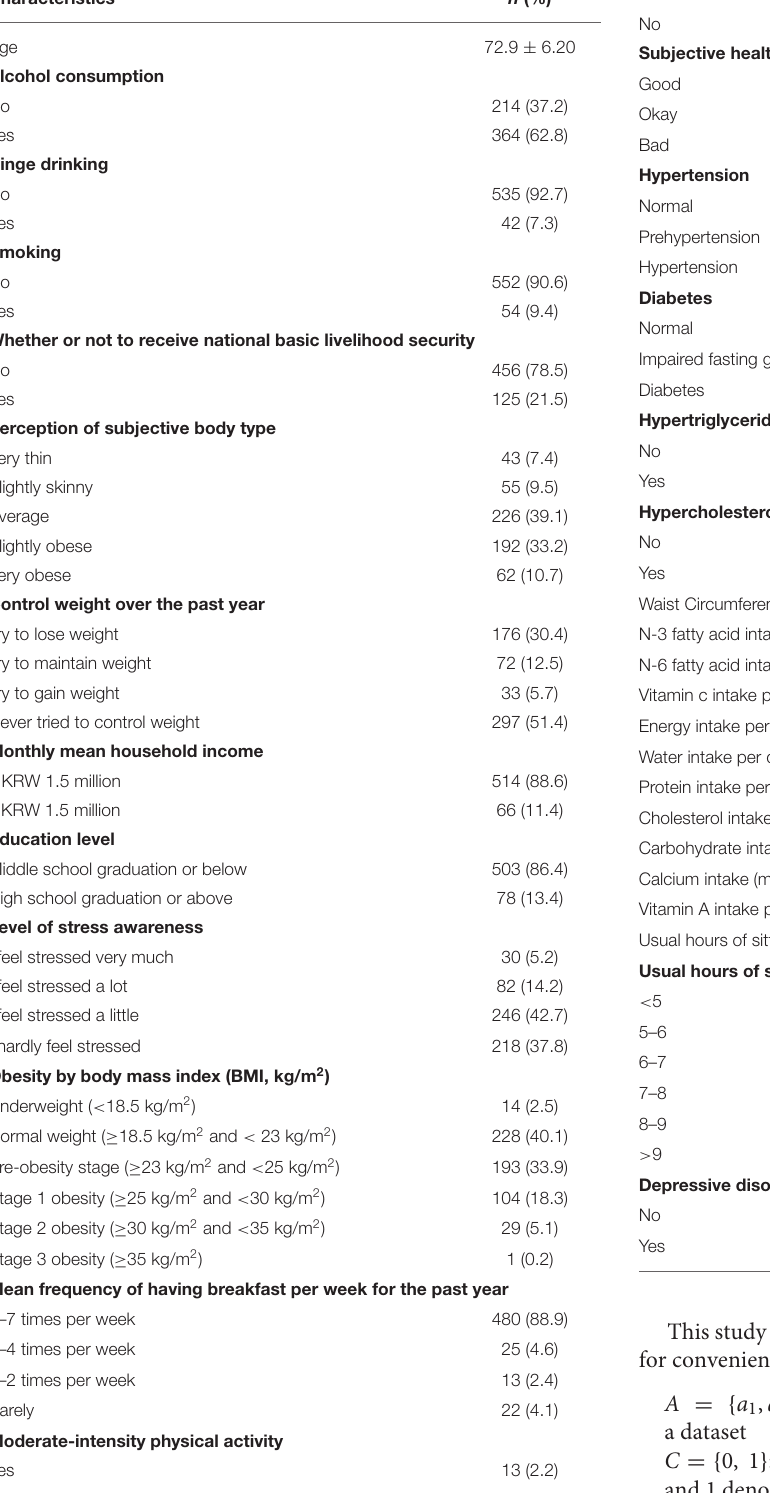
TABLE 2 | Data, measurement unit of female older adults living alone in South Korea, mean ± SD/ n (%).